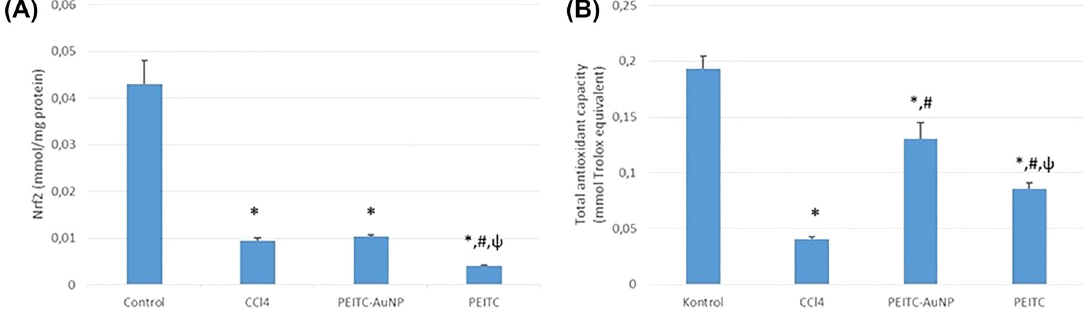
Figure 3: (A, B): E ff ects of PEITC-AuNP and PEITC on Nrf2 and total antioxidant capacity levels in CCl4-treated HepG2 cells. Data are presented as mean ± S.E. *p<0.05 vs. control; # p<0.05 vs. CCl 4 ; ψ p<0.05 vs.